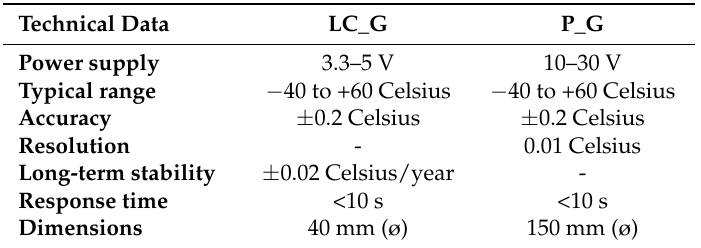
Table 3. Technical characteristics of the considered globe thermometers.